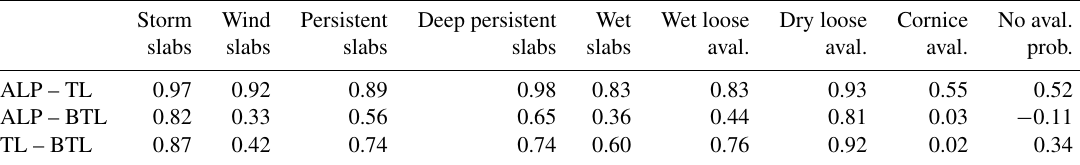
Table 3. Pearson correlation coefficients for prevalence of avalanche problem types between different elevation bands (ALP: alpine; TL: tree- line; BTL: below treeline).